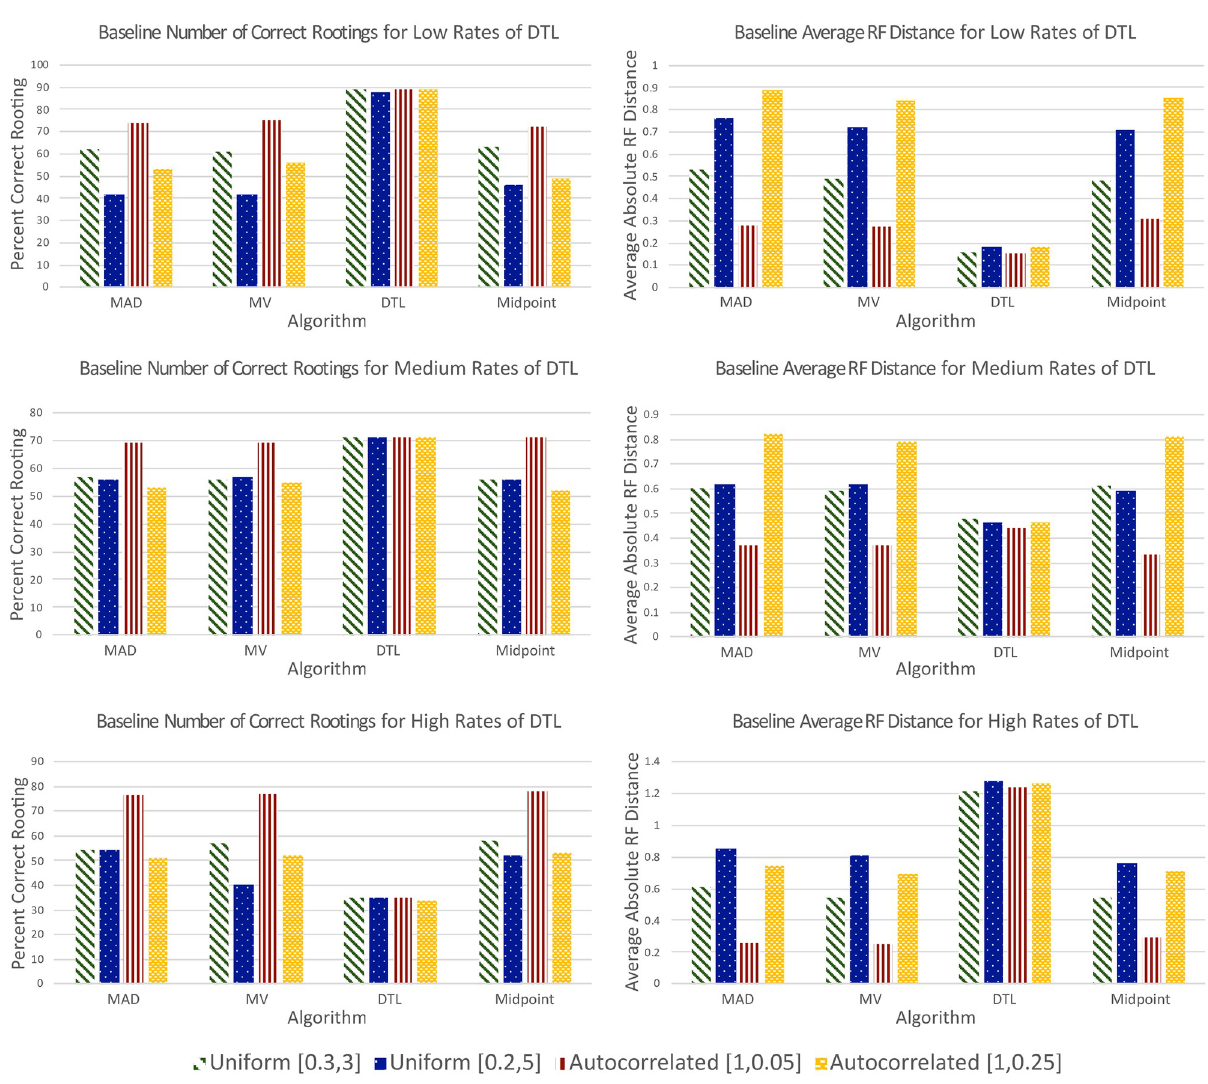
Fig 2. Results on baseline data sets. The plots on the left show, for each rooting method and each of the 12 baseline data sets, the percent of gene trees whose roots were inferred correctly. The corresponding plots on the right show the absolute average RF distances for the rooting methods and data sets. As shown, DTL rooting is most accurate on the low and medium DTL data sets and is unaffected by substitution rate variation along edges (i.e., by branch length scaling). MAD, MV, and midpoint rooting are largely unaffected by DTL event rates but are significantly affected by substitution rate variation along edges; these three rooting methods show comparable accuracy on the baseline data sets. ALE rooting performed worse than DTL rooting across all data sets (results shown in Tables A1 and A2 in S1